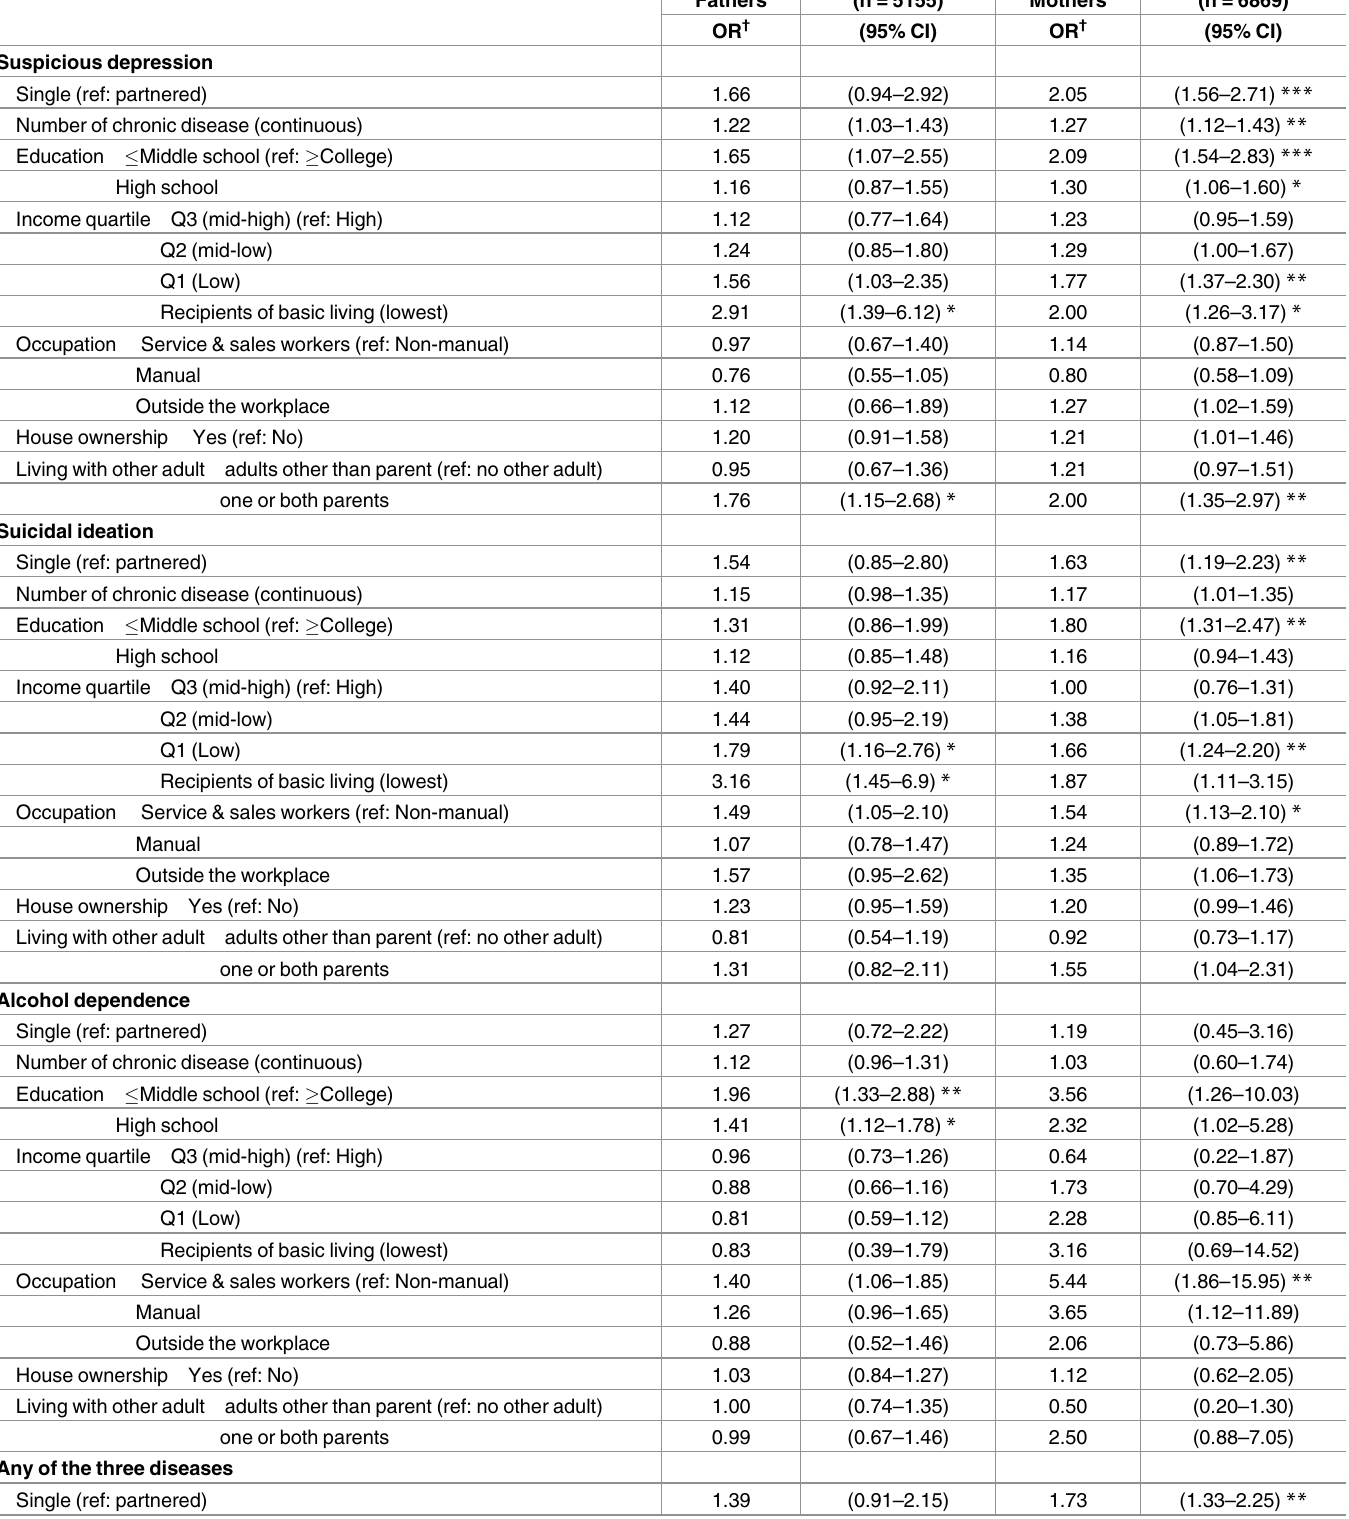
Table 4. Odds ratios of poor mental status for single parents compared to partnered